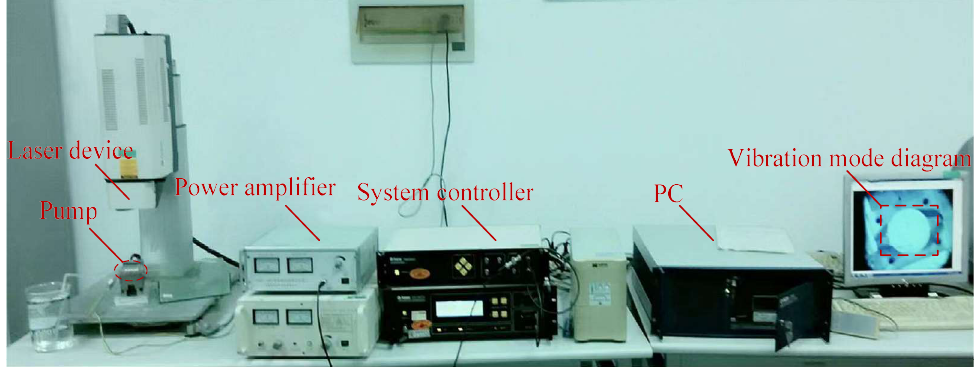
Figure 8. Experimental platform for vibration-mode test of piezoelectric vibrator.